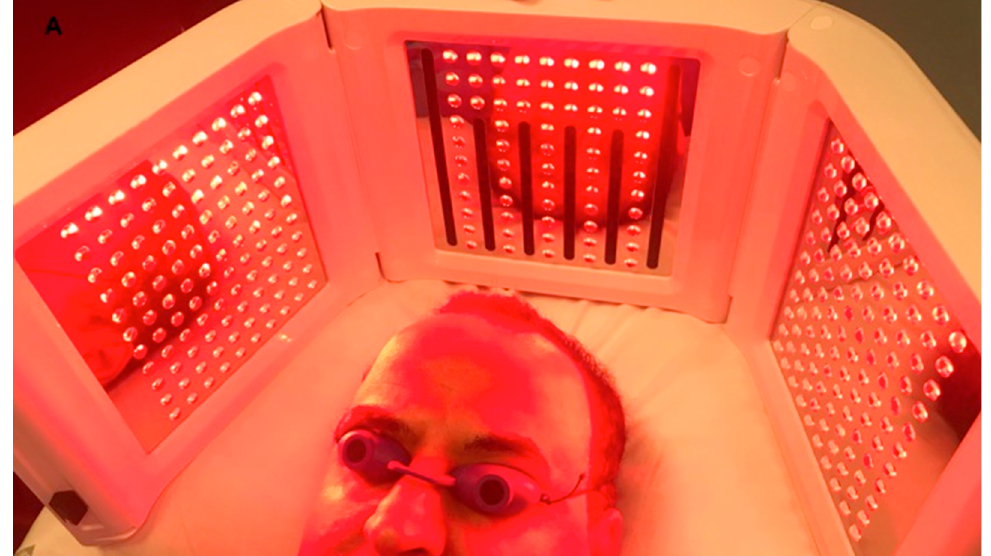
Figure 1. A non-smoker 58-year-old male patient classified androgenetic alopecia (AGA) 3V according to Norwood–Hamilton Scale. During Low level led therapy treatment performed by Geno-Led